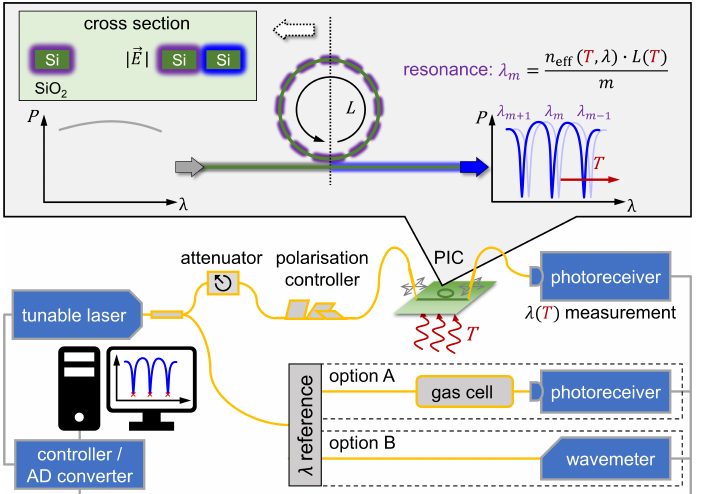
Figure 1. ( Upper part ): The basic concept of photonic thermometry based on photonic integrated circuits (PICs) is the determination of the temperature dependent resonance wavelength shift. ( Lower part ): Sketch of the set-ups used for the precise thermal and optical characterisation of PICs with two different options for the traceability of the wavelength to the international system of